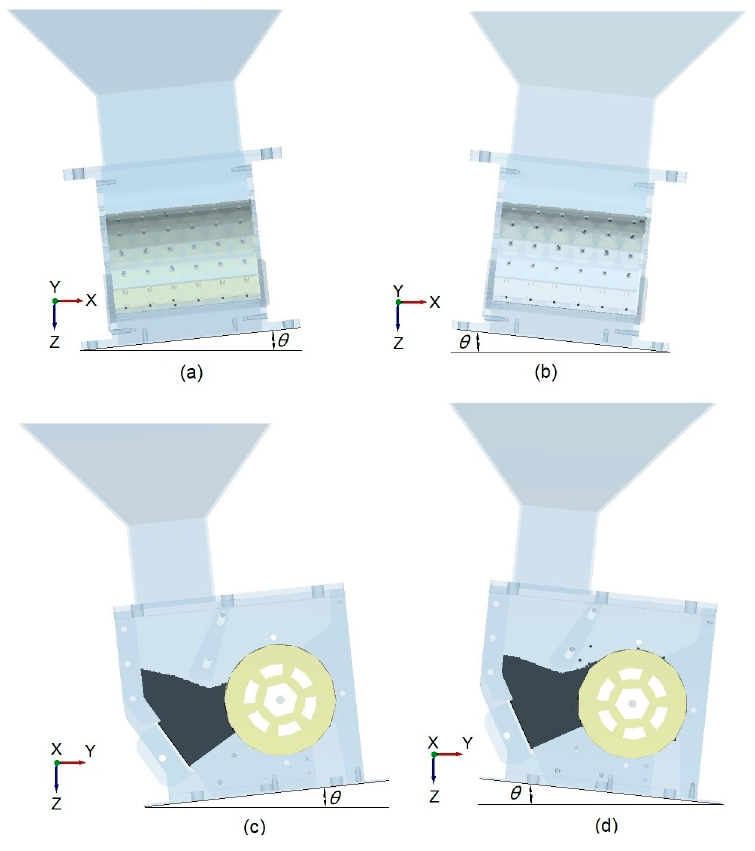
Figure 2. Schematic diagram of working processes of a centralized seed-metering device: ( a ) tilting to − X direction, ( b ) tilting to X direction, ( c ) tilting to − Y direction, and ( d ) tilting to Y direction. Note that θ is the inclination angle.